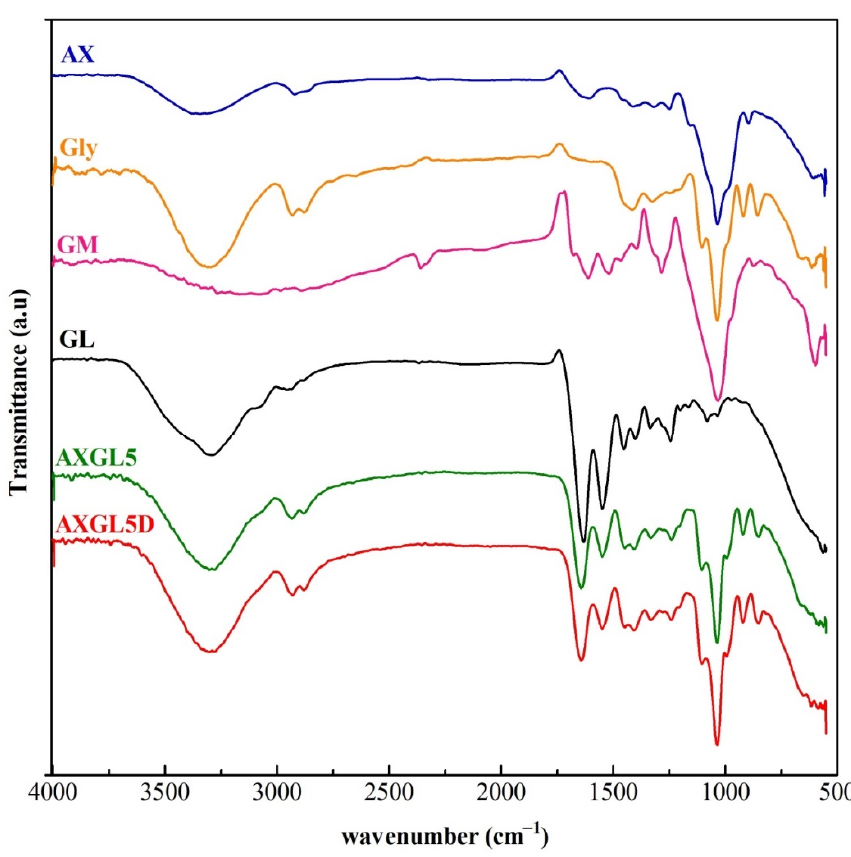
Figure 2. Fourier-transform infrared (FTIR) spectra of arabinoxylan (AX), gelatin (GL), gentamicin (GM), glycerol (Gly), blank AX-GL film (AXGL5), and GM-loaded film (AXGL5D).